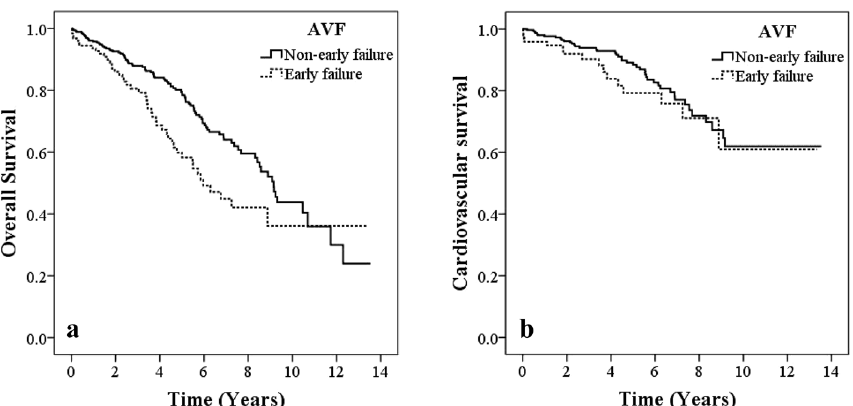
Figure 1a reveals the Kaplan–Meier survival curves for overall survival between groups of early AVF failure and non-early AVF failure. Analysis of results showed that early failure of AVF was associated with significantly reduced overall survival than was non-early AVF failure (log-rank test; p = 0.002).